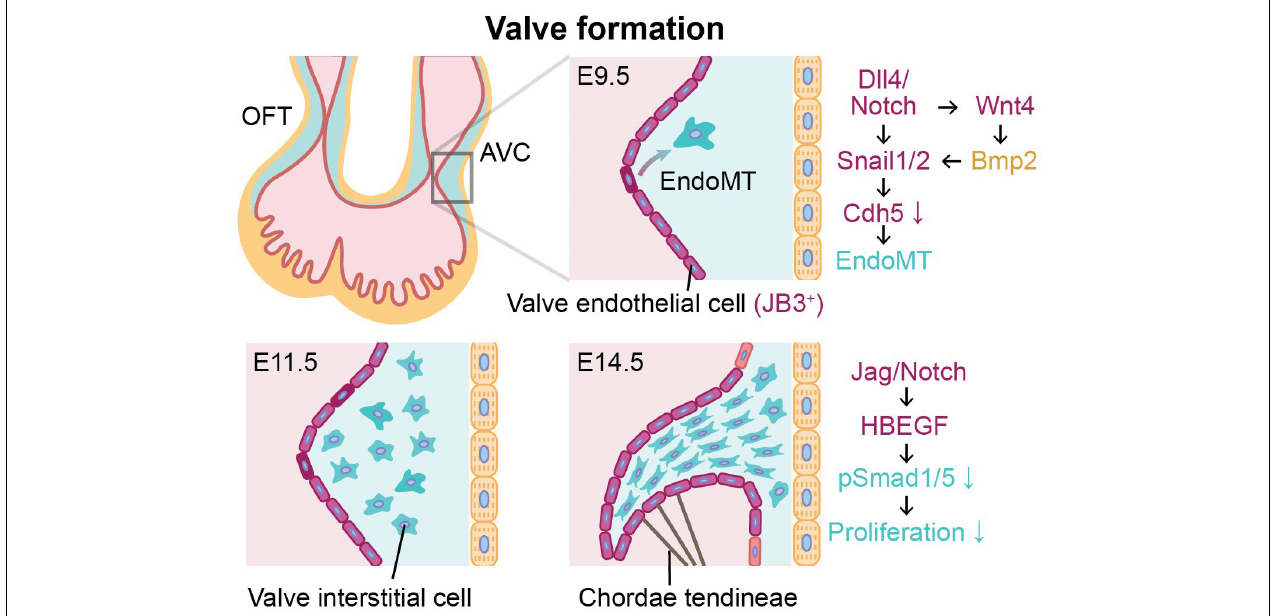
FIGURE 2 | Endothelial-to-mesenchymal transition (EndoMT) of valve endothelial cells expressing JB3 and angiocrine signaling during valve formation between E9.5 and E14.5. Valve formation is initiated by EndoMT of valve endothelial cells (purple) to become valve interstitial cells (blue) in cardiac jelly. During valve formation, the cushion is remodeled and elongated by valve interstitial cells, and the mature valve leaflet is supported by chordae tendineae. Endocardial cells and cardiomyocytes are indicated in red and yellow, respectively. OFT, outflow tract; AVC, atrioventricular canal; E9.5, E11.5, E14.5, mouse embryonic day 9.5, 11.5, 14.5,